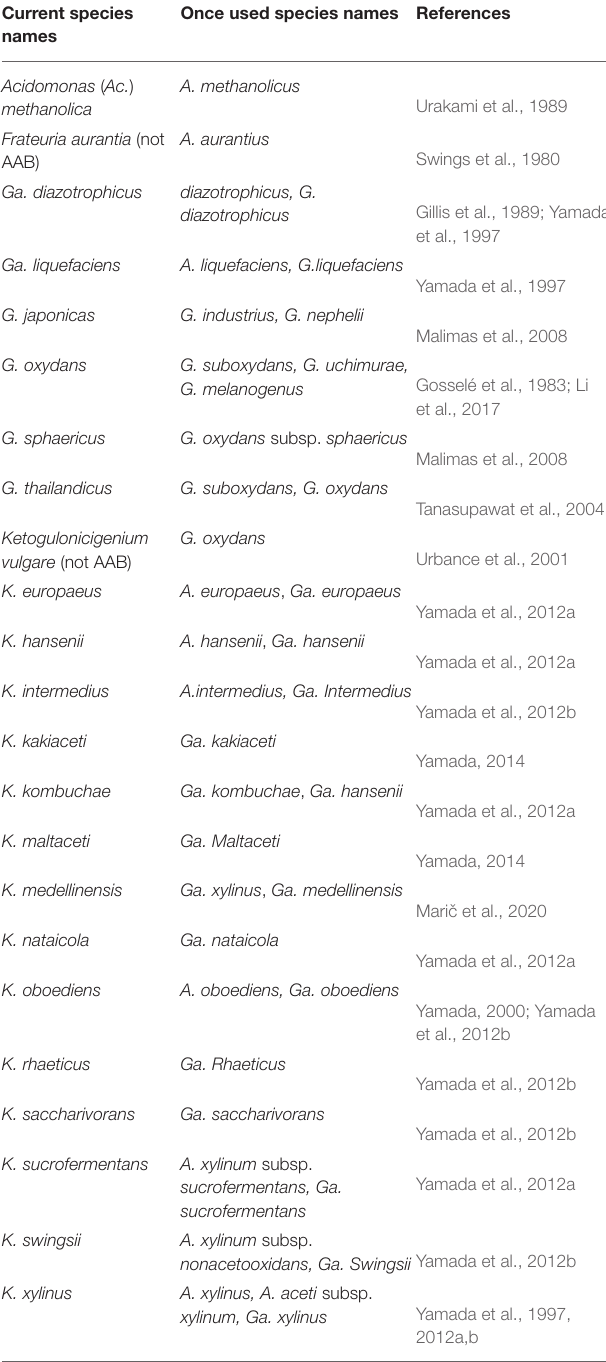
TABLE 1 | The changes of classification status of AAB genera and species in recent